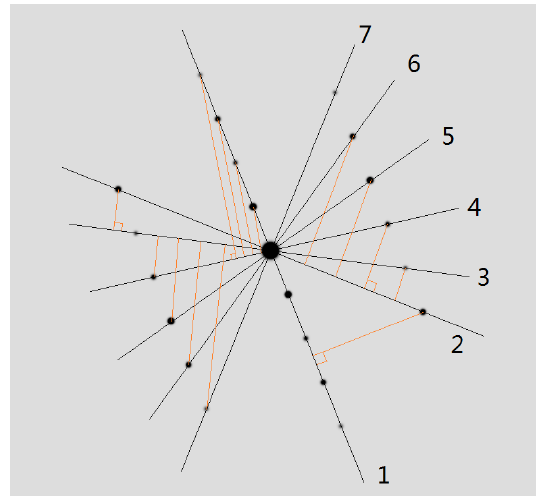
Figure 1. A good electron diffraction pattern. Numbers 1–7 mark seven lattice rows in seven different directions (black lines). Four row distances (rows 1–4) are shown as (red) lines normal to their directions. Table 1. Calculated and measured distances between rows and their discrepancies in electron diffraction patterns of talc (Figure 2a).